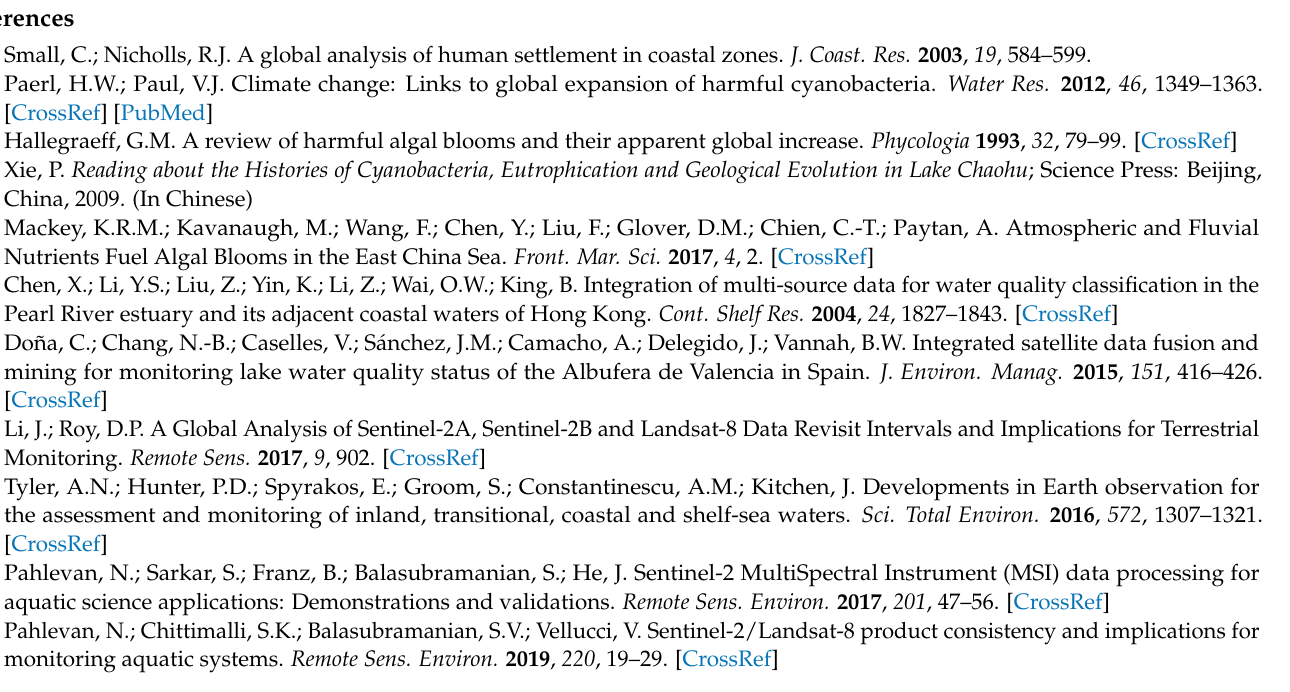
A pairs; Figure S6: Inter-comparison of remote sensing reflectance (R_rs) for OLI – MSI-B pairs; Table S1: Landsat 8 OLI and Sentinel 2-MSI A/B near- simultaneous overpass images used for spectral consistency analysis and band adjustment; Table S2: Landsat-8 OLI and Sentinel 2-MSI A/B images used for Total suspended solids (TSS) time series analysis over Hong Kong; Table S3: Landsat-8 OLI and Sentinel 2-MSI A/B images used for Total suspended solids (TSS) time series analysis over Lake Chaohu; Table S4. Landsat-8 OLI and Sentinel 2-MSI A/B images used for floating algal area comparison; Table S5. Landsat-8 OLI and Sentinel 2-MSI A/B images used for floating algal bloom tracking over the Yellow